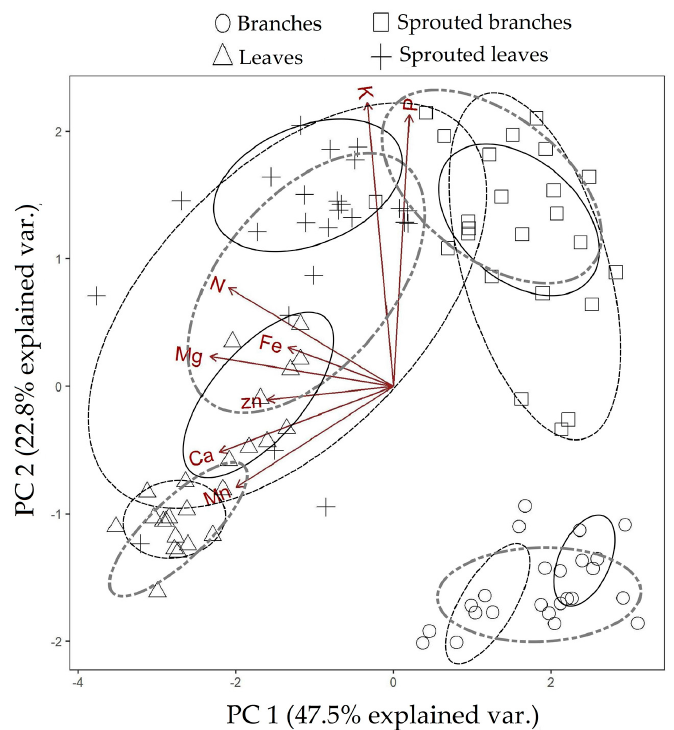
Figure 2. Biplot graph with two first principal components (PC 1 and PC 2) showing the ordering of branch and leaf chemical attribute data from “reference” and “regrowth” material collected by sequential management of rosewood mass in the three study areas. Ellipses with dash, dash dot dot and solid line, correspond to areas C10, C12 and C17 respectively.